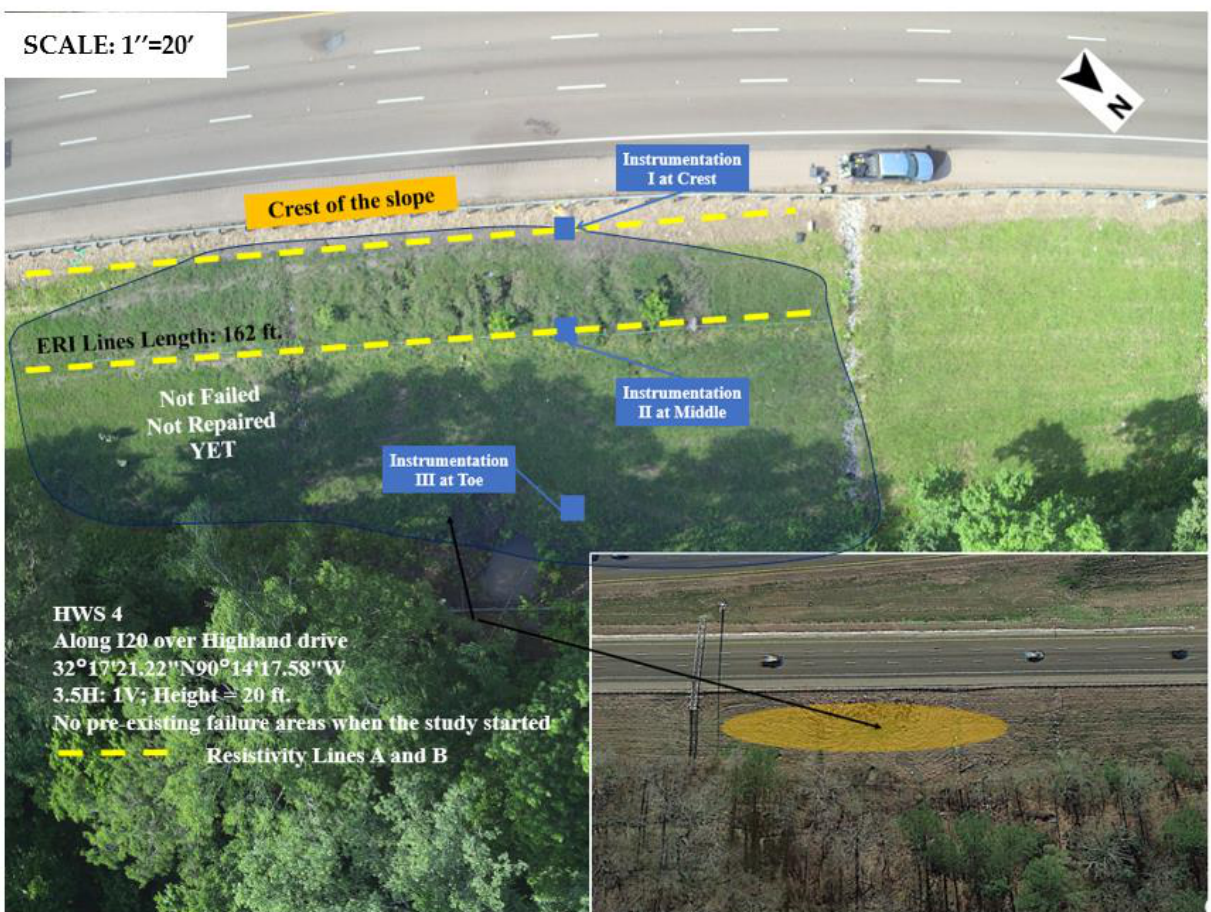
Figure 20. HWS 4 ERI and instrumentation layouts along with its characteristics (drone image-top view) ( 1′ = 1 ft = 0.305 m). view) (1 (cid:48) = 1 ft = 0.305